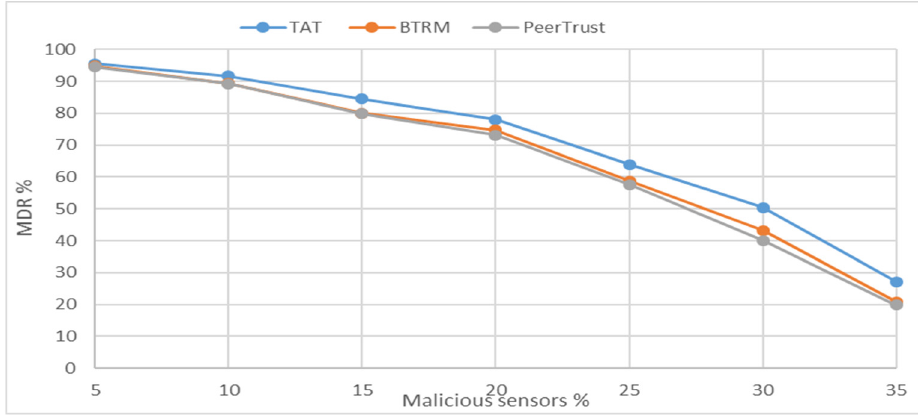
Figure 6. MDR for TAT, PeerTrust, and BTRM Models.